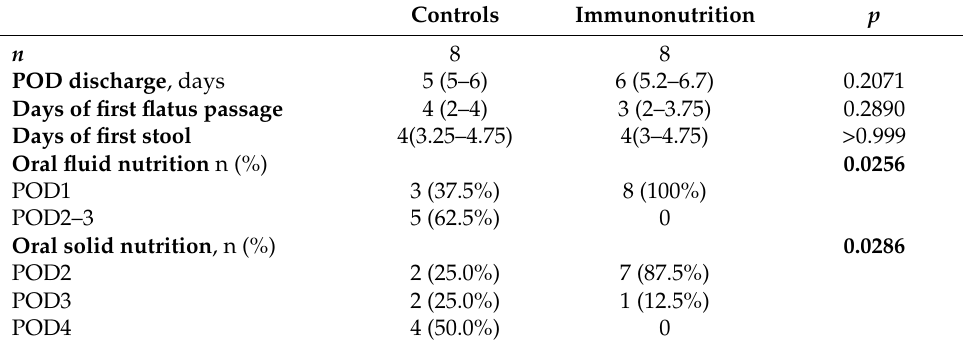
Table 2. Post-operative items of the two groups of Crohn’s disease patients.